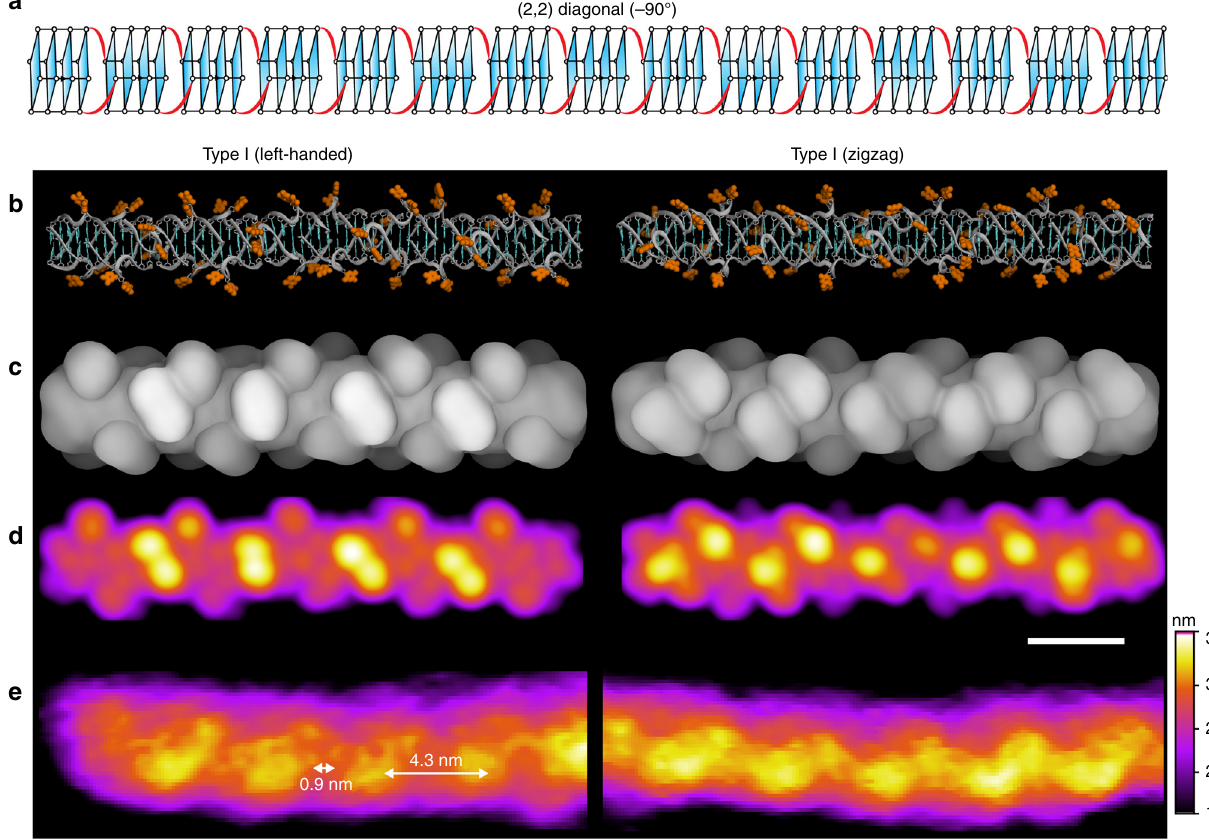
Fig. 8 Comparison of proposed model with AFM observation of Type I G-wires. a Schematic representation of − 90° rotamer of the "(2,2) Diagonal" model containing 15 G-tetrad blocks, corresponding to a length of ~ 20 nm. b The G-wire structural model for the − 90° rotamer of the "(2,2) Diagonal" arrangement in two different molecular orientations. Thymines are shown in orange. c Surface representation of the above structures, where the grayscale intensity is related to the distance from the plane over which the molecule is lying. Atomic radii for Thymines have been altered for visualization purposes. d AFM images generated by simulated scanning with a paraboloid AFM tip. The length scale (white bar) is 4 nm. e Experimentally observed AFM images of Type I G-wires showing two types of periodic surface